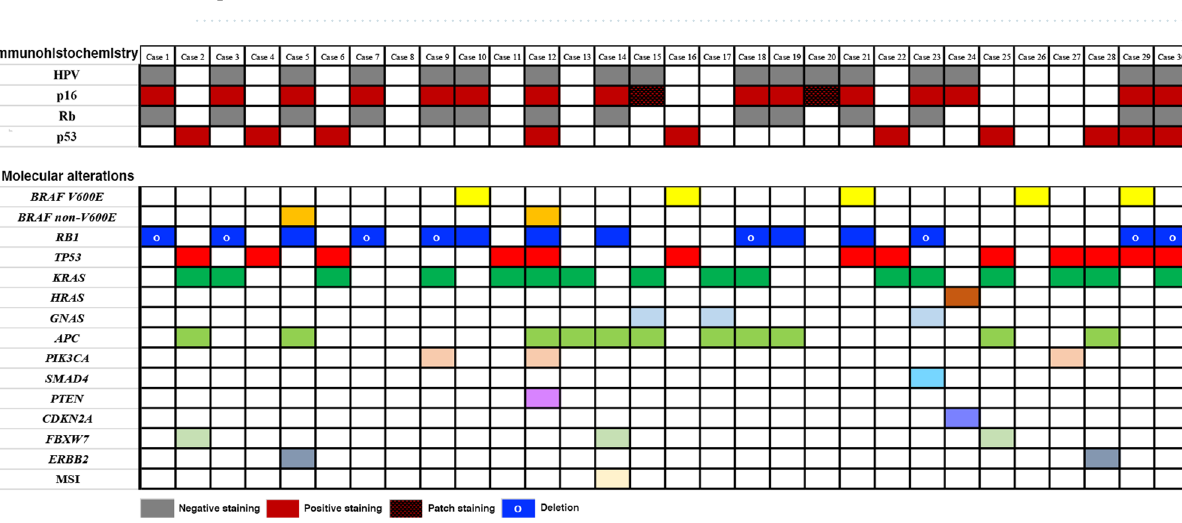
Figure 1. Rb1/p16 pathway deregulation in colorectal NECs revealed by immunohistochemistry and next- generation sequencing. ( A ) Representative micrograph of small-cell NEC displaying small to medium sized cells with a high nuclear-cytoplasmic ratio, scant cytoplasm and frequent mitotic figures. ( B ) Representative micrograph of large-cell NEC showing large polygonal cells with prominent nucleoli and moderate amount of eosinophilic cytoplasm. ( C ) Intense and diffuse nuclear staining for p53. ( D ) Intense and diffuse cytoplasmic staining for p16. ( E ) Complete loss of Rb1 expression. ( F ) Deep deletion of RB1 on a normalized sequencing depth (red circle).